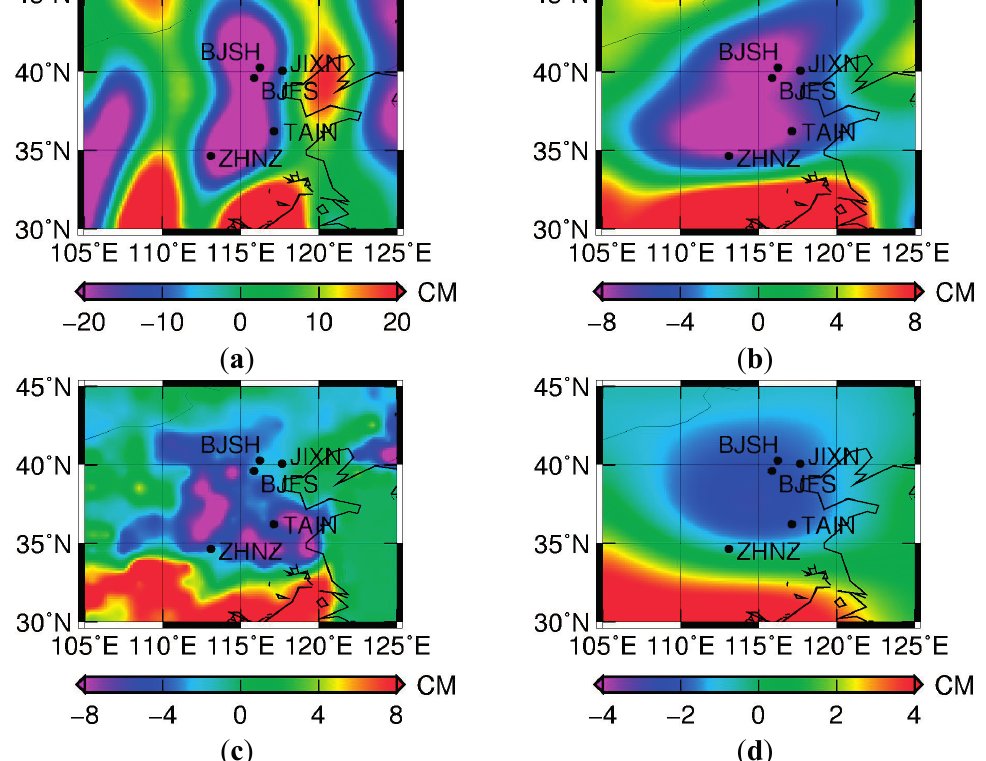
Figure 2. Total water storage (in terms of equivalent water height) changes derived by GRACE and GLDAS monthly data of July 2010 with respect to the mean field from 2004 to 2010. ( a ) Derived from GRACE without filtering; ( b ) Derived from GRACE using destriping and smoothing algorithms ( i.e. , (55, 0) ↔ (20, 20), k = 20 decorrelation and r = 300 km Gaussian smoothing); ( c ) Derived from GLDAS without filtering; ( d ) Derived from GLDAS using destriping and smoothing algorithms ( i.e. , (55, 0) ↔ (20, 20), k = 20 decorrelation and r = 300 km Gaussian smoothing). The black dots are locations of GPS sites. Note the different scale of the